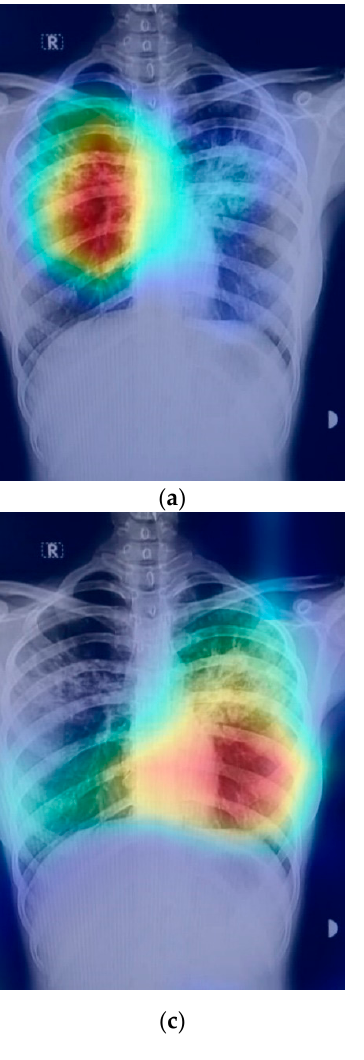
Figure 14. Grad-CAM results on local Pakistani COVID-19 chest X-ray: ( a ) DenseNet-121; ( b ) VGG16; ( c ) MobileNet; ( d ) ResNet-50.